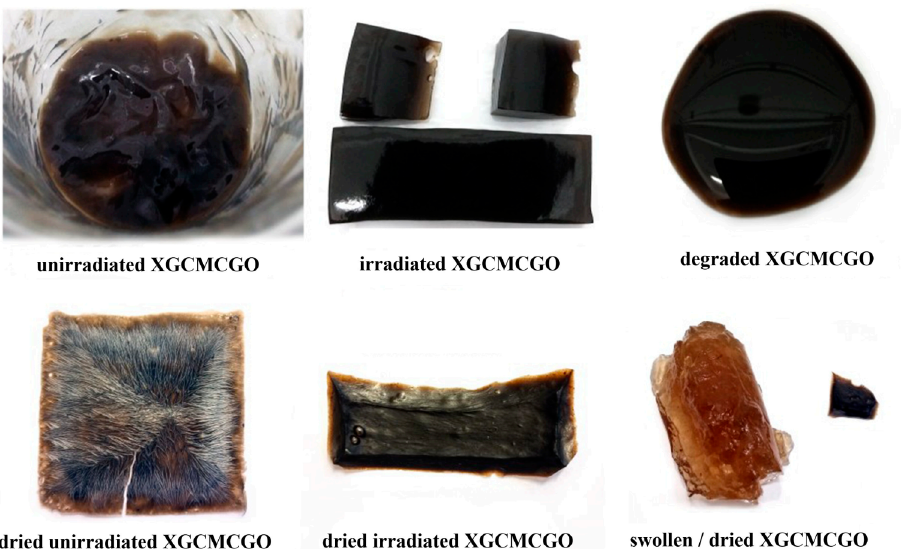
Figure 7. XGCMCGO hydrogels in different